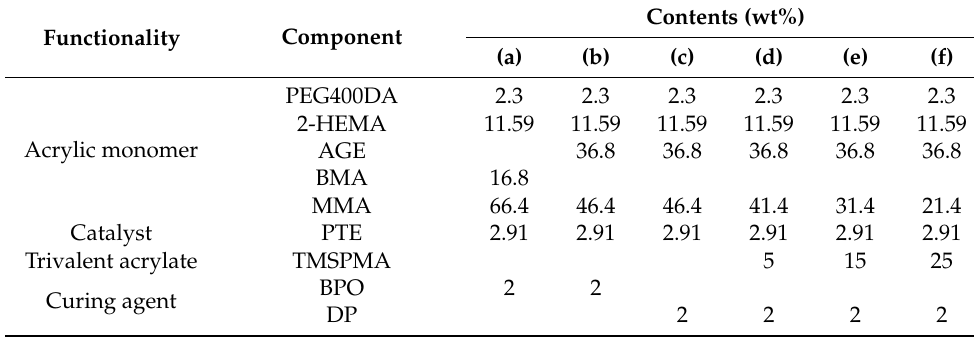
Table 1. The split composition of the comparative groups (weight